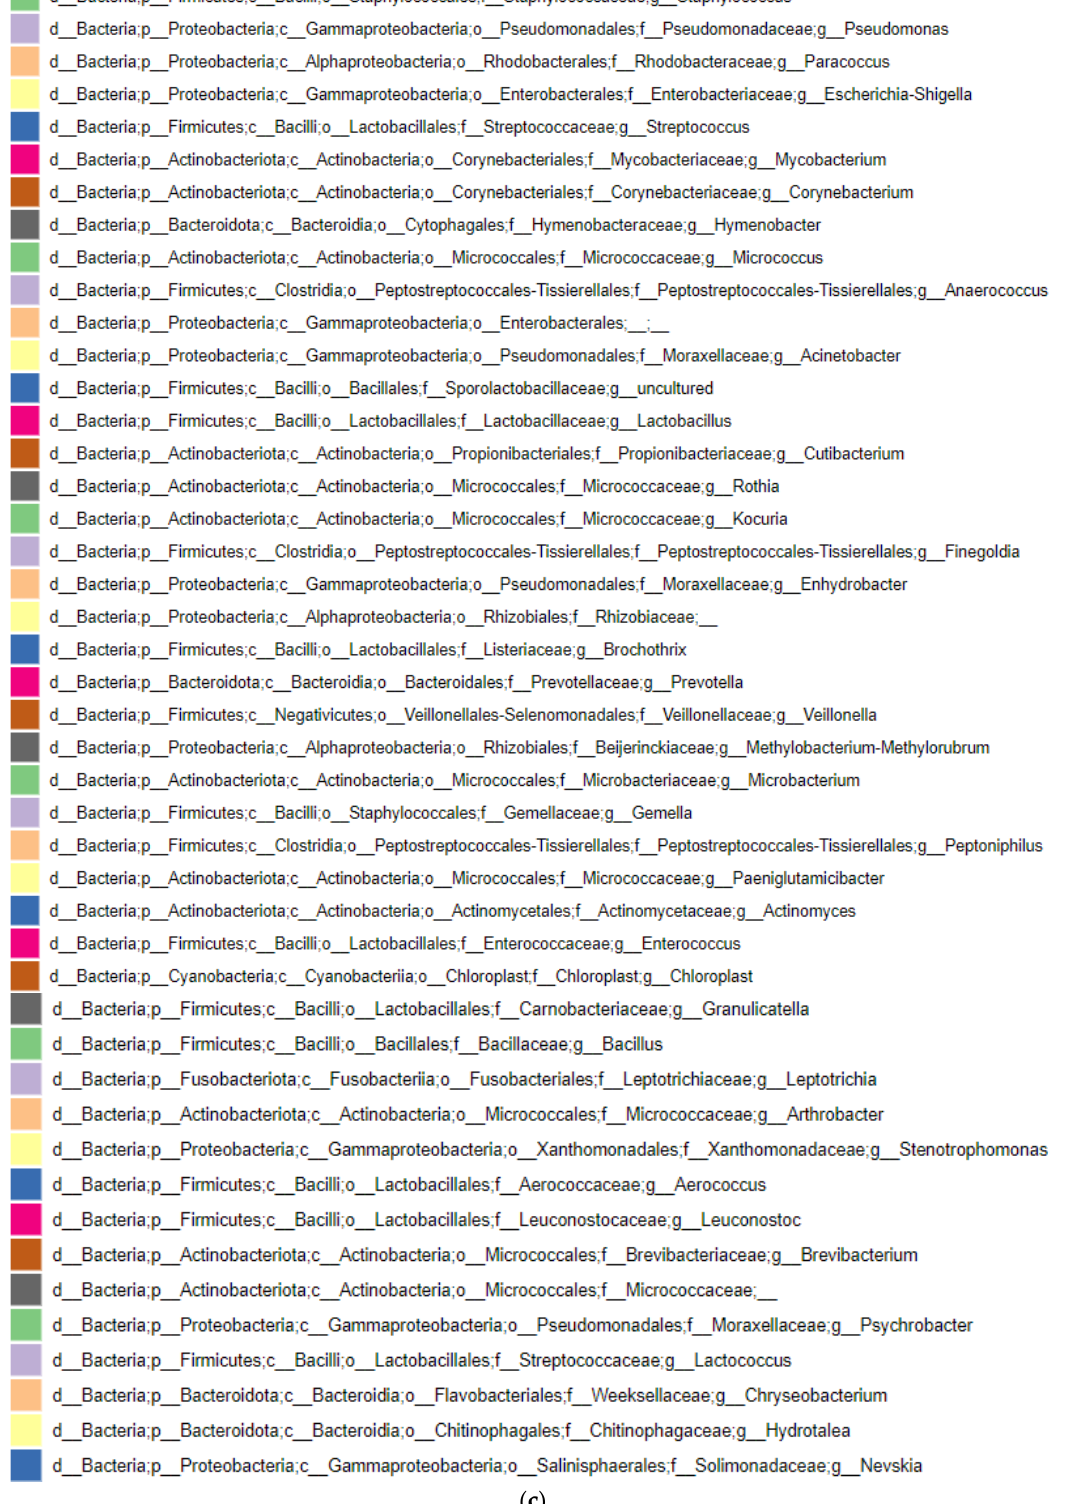
Figure 1. Stacked bar plots presenting the individual’s distribution of microorganisms in prurigo nodularis (PN), healthy volunteers (HV) and atopic dermatitis (AD) ( a ) at the phylum level (level 2), ( b ) at the class level (level 3) and ( c ) at the genus level (level 6).